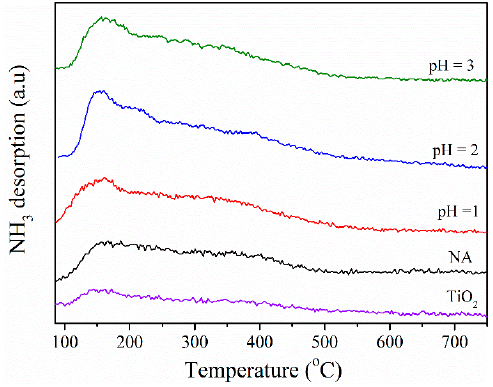
Figure 5. NH 3 ‐ TPD patterns of BFS ‐ TiO 2 samples made at different pH values of hydrolysis and commercial TiO 2 .